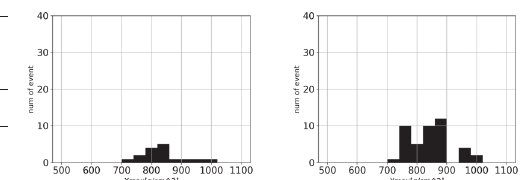
Table 4: Composition ratios in three energy regions for the Background and HotSpot